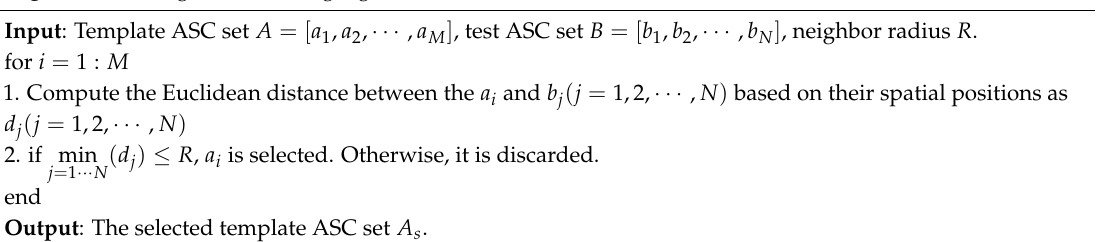
Algorithm 2. Neighbor matching